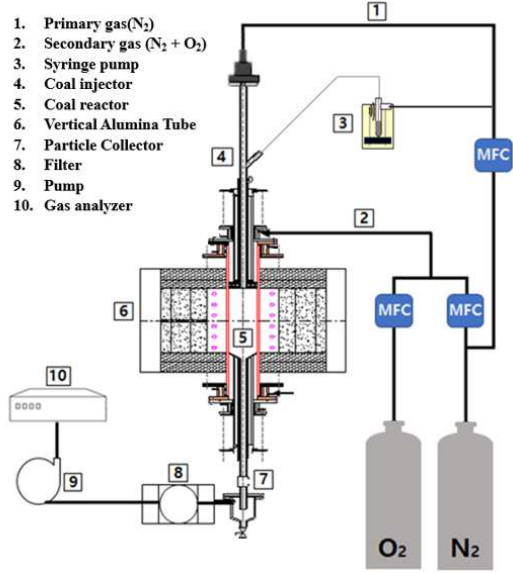
Figure 1. Schematic of the drop tube furnace.